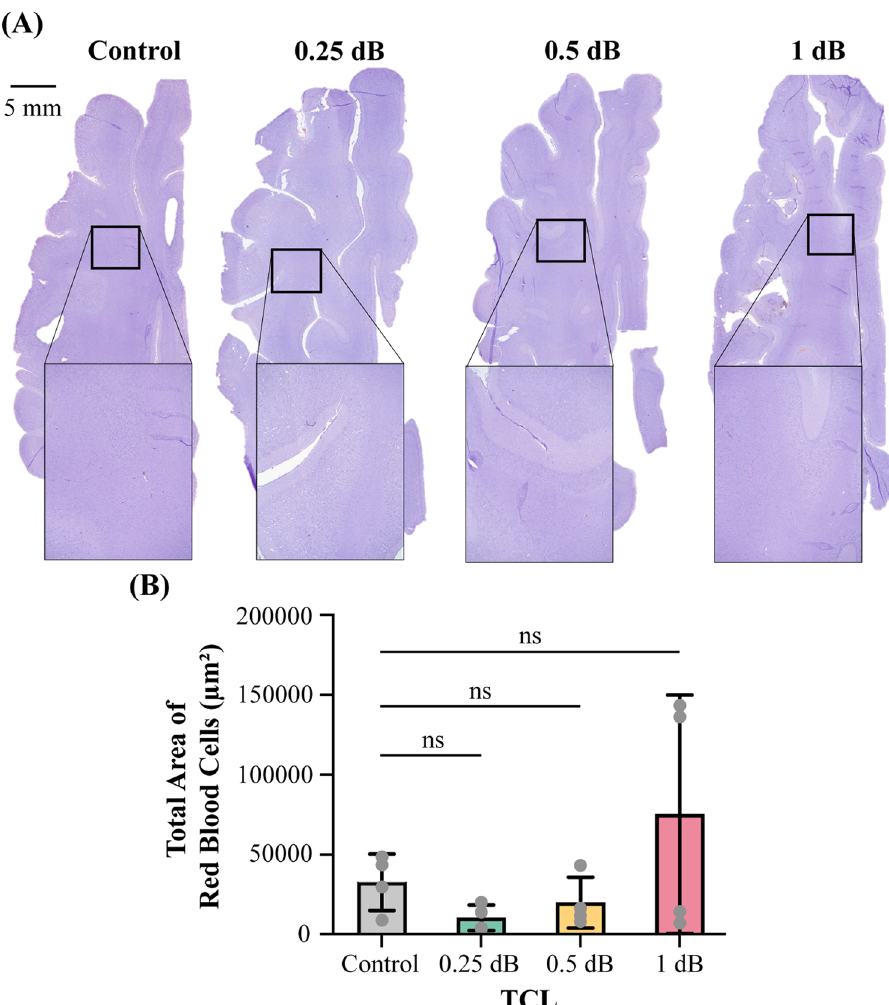
Figure 4. Safety evaluation of feedback-controlled FUS-BBBO in pig studies. ( A ) Representative H&E staining of the FUS-treated site at different TCL and non-treated site. ( B ) Comparison of total area of red blood cells of the control sites without FUS treatment and sites with FUS-treated at different TCLs. The bar plot in ( B ) shows the mean and standard deviation. Each circular point represents the result obtained from each target. (Tukey’s test * P < 0.05; ns: no